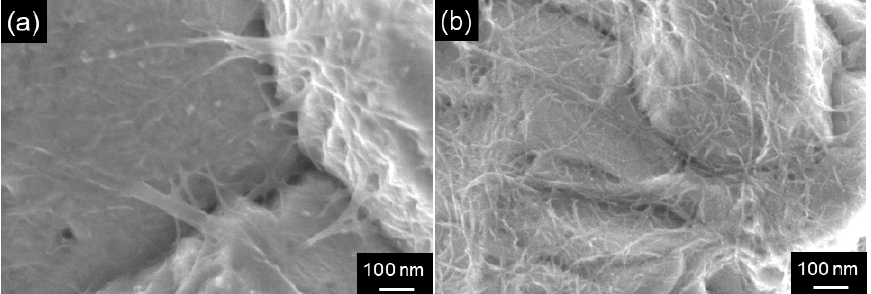
Figure 12. Surface SEM images of Cu/SWCNT composite films by electroless deposition formed from the plating baths treated by different disintegration methods. ( a ) an ultrasonic homogenizer, ( b ) a collision mechanical atomizer. (Figure 12 is adapted from [33]).